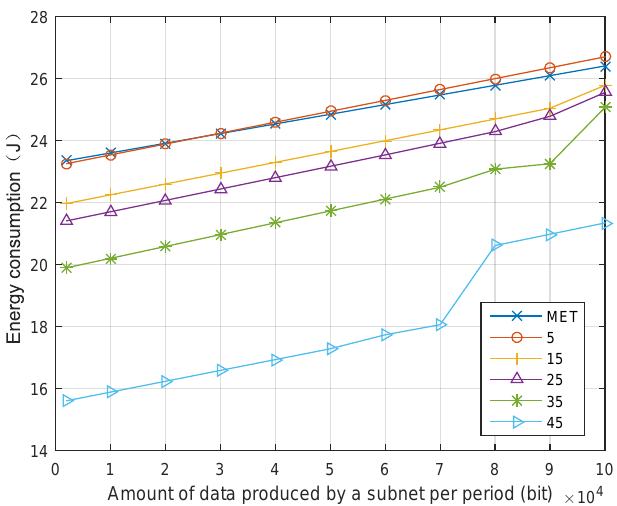
Figure 6. Energy consumption with different load.